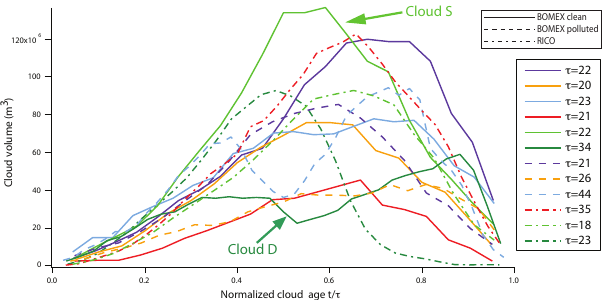
Figure 2. Cloud volume vs. normalized time. Lifetime τ is in min- utes.